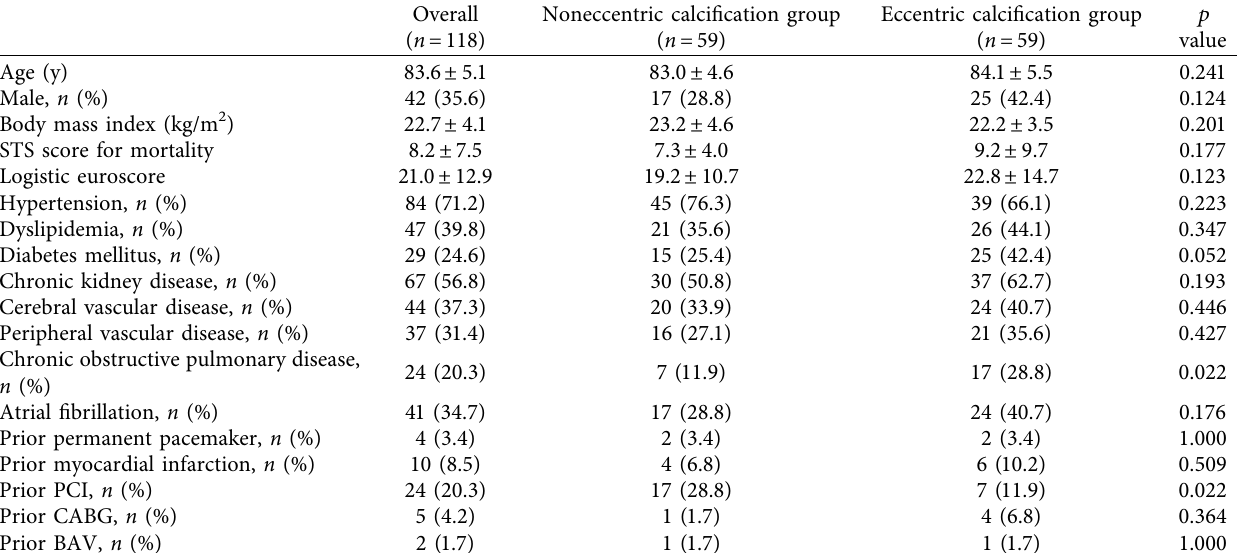
Figure 1: Transcatheter heart valve distortion and multislice computed tomography analysis. A normal expanded transcatheter heart valve (THV) and distorted THV in a multislice computed tomography (MSCT) volume-rendered view (a). Using the postprocedural MSCT, a 3D-volume-rendered view of THV was constituted. The length of the stent frame on the center of each cusp was measured. Valve distortion score (VDS) was defined as the difference between the longest and shortest stent frame lengths (b). The THV stent frame was geometrically evaluated for maximal and minimal orthogonal diameters at the four levels of THV: THV inflow, native annulus, mid-THV, and THV outflow. The cross-sectional eccentricity index was defined as follows: (1 − short diameter/long diameter) × 100 (c). Table 1: Patients